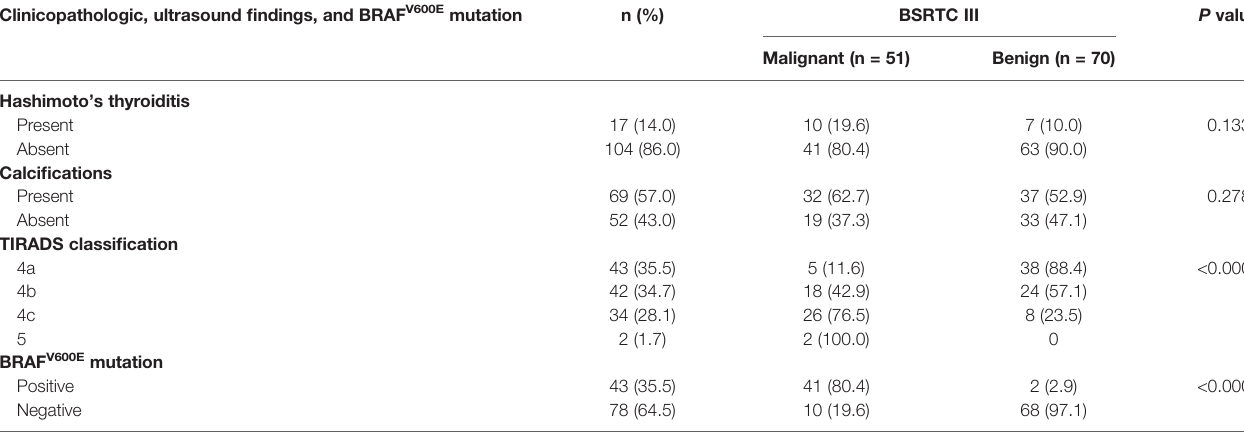
TABLE 6 | Correlations of clinicopathologic and ultrasound fi ndings and BRAF V600E mutation with fi nal diagnosis in BSRTC III category. Clinicopathologic, ultrasound fi ndings, and BRAF V600E